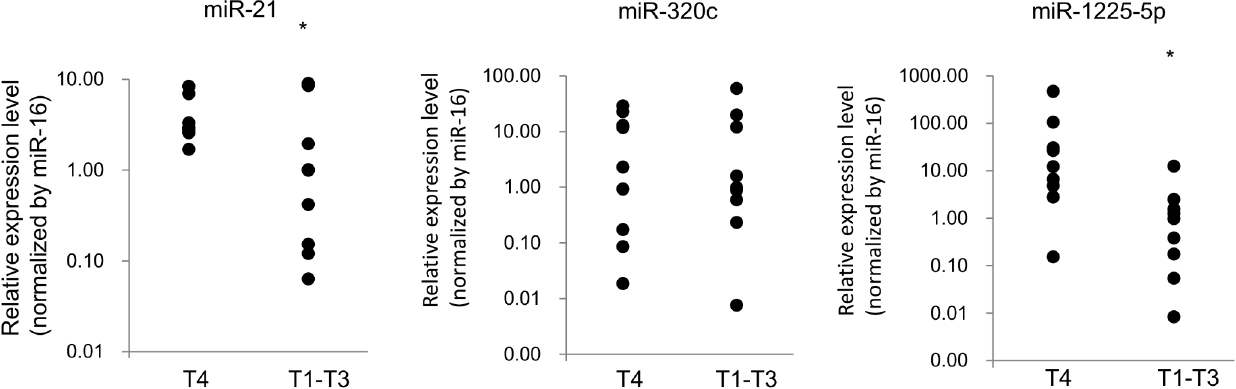
Fig 6. Relative expression levels of exosomal miRNAs in intraoperative peritoneal lavage fluid of T4 and T1 – T3 gastric cancer patients. An asterisk indicates P < 0.05.